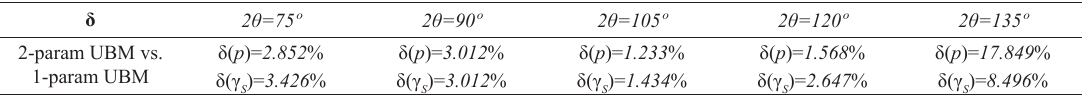
Figure 9. Computational dependencies of ECAE punching pressure p/2k (a, c) and the total plastic shear γ factor m for the ECAE Segal 2θ -dies with 2θ=120 °(a, b) and 2θ=135° ( c , d ), derived by two-parameter UBM (○○○), and one-parameter UBM (▬▬). Table 4. Comparison of upper bound-estimated computational results for ECAE punching pressure p/2k and total accumulated plastic strain γ derived with the introduction of two-way UBM techniques for Segal 2θ S